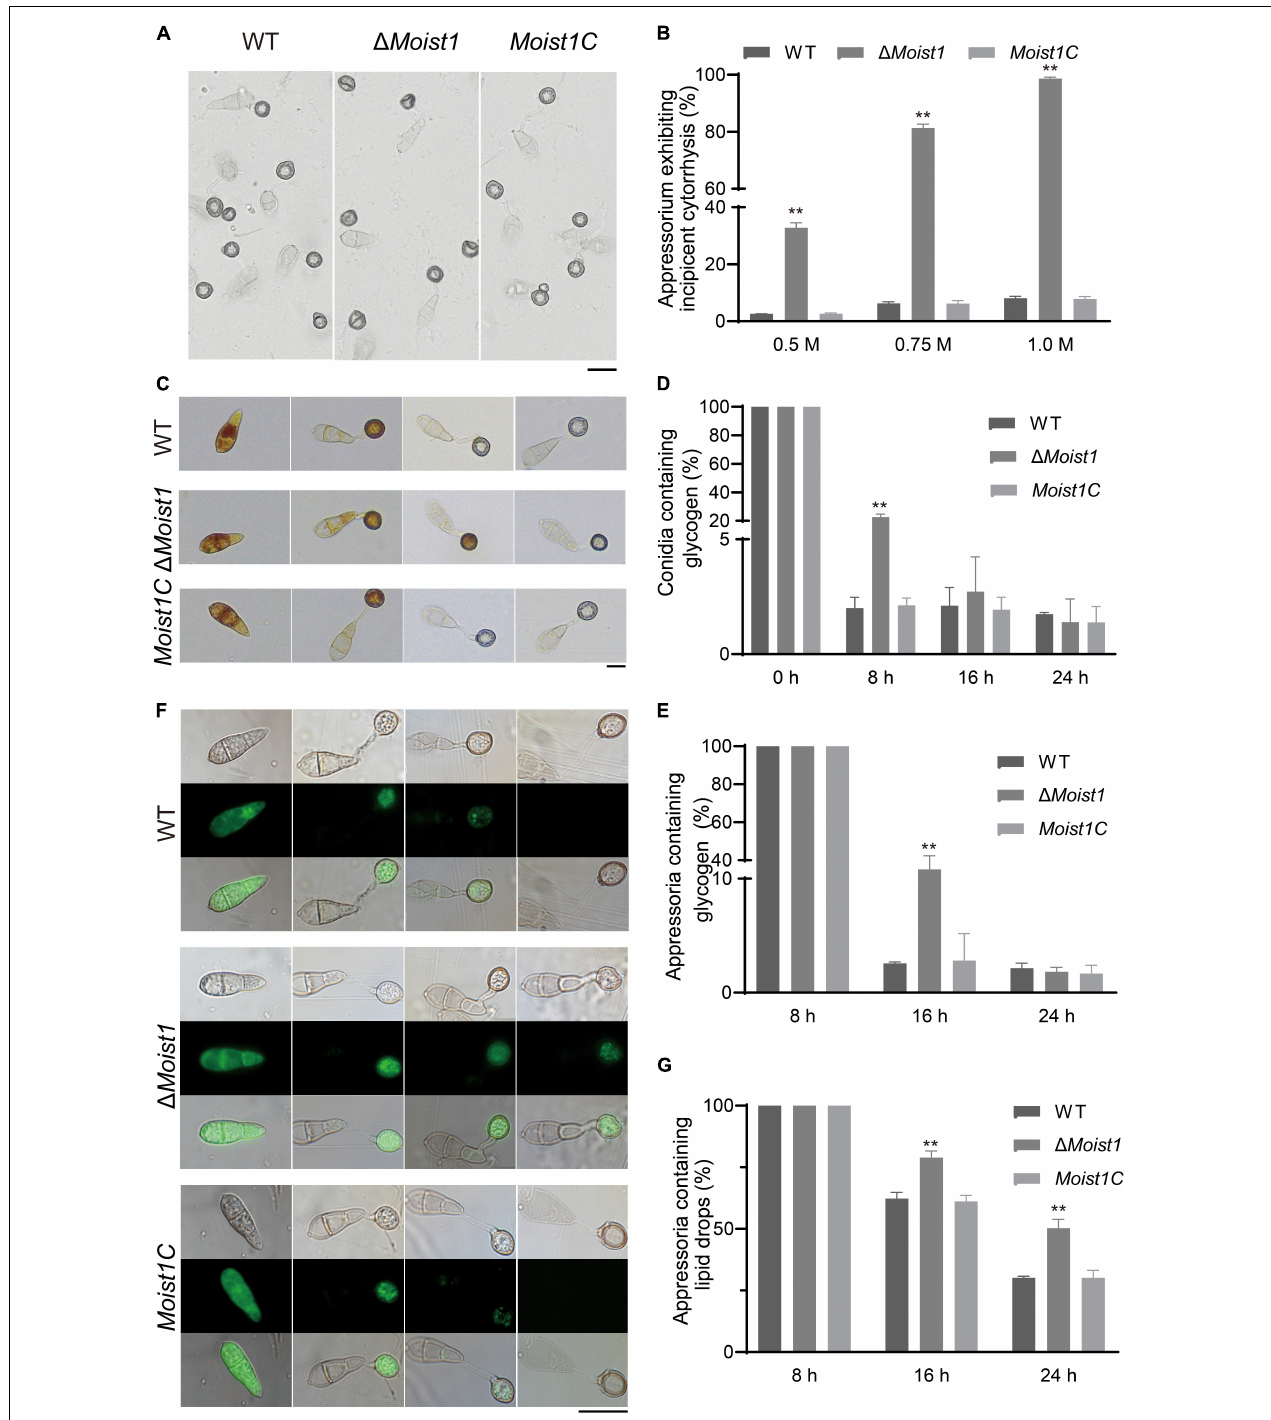
FIGURE 3 | MoIst1 is essential for appressorium turgor and the degradation of glycogen and lipid droplets. (A) Collapse of appressoria at 1.0 M glycerol. Bar = 20 µ m. (B) Collapse rates of appressoria exposed to 0.25, 0.5, and 1.0 M glycerol solutions. The standard deviation is represented by error bars. Tukey’s test was used to test significant differences: ** P < 0.01. (C) Changes in glycogen during appressorium development. Bar = 20 µ m. (D) The proportion of conidia containing glycogen. The standard deviation is represented by error bars. Tukey’s test was used to test significant differences: ** P < 0.01. (E) The proportion of appressoria containing glycogen. The standard deviation is represented by error bars. Tukey’s test was used to test significant differences: ** P < 0.01. (F) Changes in lipid droplets during appressorium development. Bar = 50 µ m. (G) The proportion of appressoria containing lipid droplets. The standard deviation is represented by error bars. Tukey’s test was used to test significant differences: ** P <